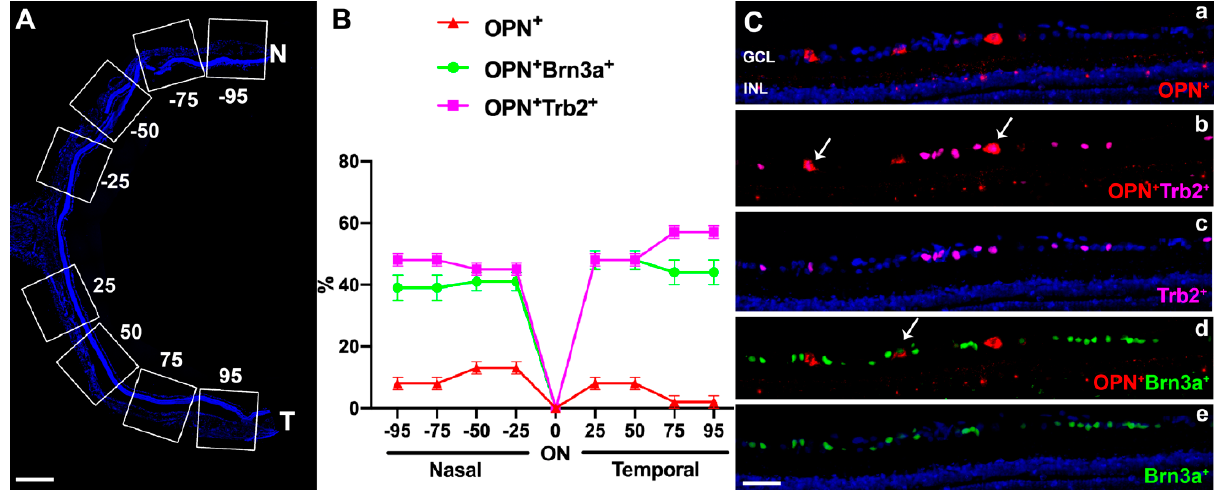
Figure 4. Coexpression of Brn3a, OPN and Tbr2 in cross retinal sections. ( A ) Fluorescent micrograph from a 16 µ m thick frozen cross-section on the horizontal naso-temporal axes of a control eye indicating the areas analyzed for counting double labelled retinal neurons at equivalent distances from the optic nerve (ON) to the periphery of the retina (25%, 50%, 75%, and 95%, considering 100% the length of each hemi-retina). N: Nasal, T: Temporal. Scale bar = 1 mm. ( B ) Graphs illustrating the proportions of RGCs that were labelled only with OPN (OPN + ) or double labelled with Brn3a (OPN + Br3a + ) or Tbr2 (OPN + Tbr2 + ) in micrographs obtained at different retinal eccentricities (as depicted in A), from three different cross sections in each of the four control eyes. ( C ). Fluorescence micrograph of a retinal cross section, at approximately 50% from the ON, illustrating immunolabeling with OPN + (red, a), Tbr2 + (magenta, c) and Brn3a + (green, e) as well as the double-labelled OPN + Tbr2 + (b) and OPN + Brn3a + (d). Arrows point to double-labelled cells. The section was counterstained with DAPI. GCL, ganglion cell layer. INL, inner nuclear layer. Scale bar = 50 µ